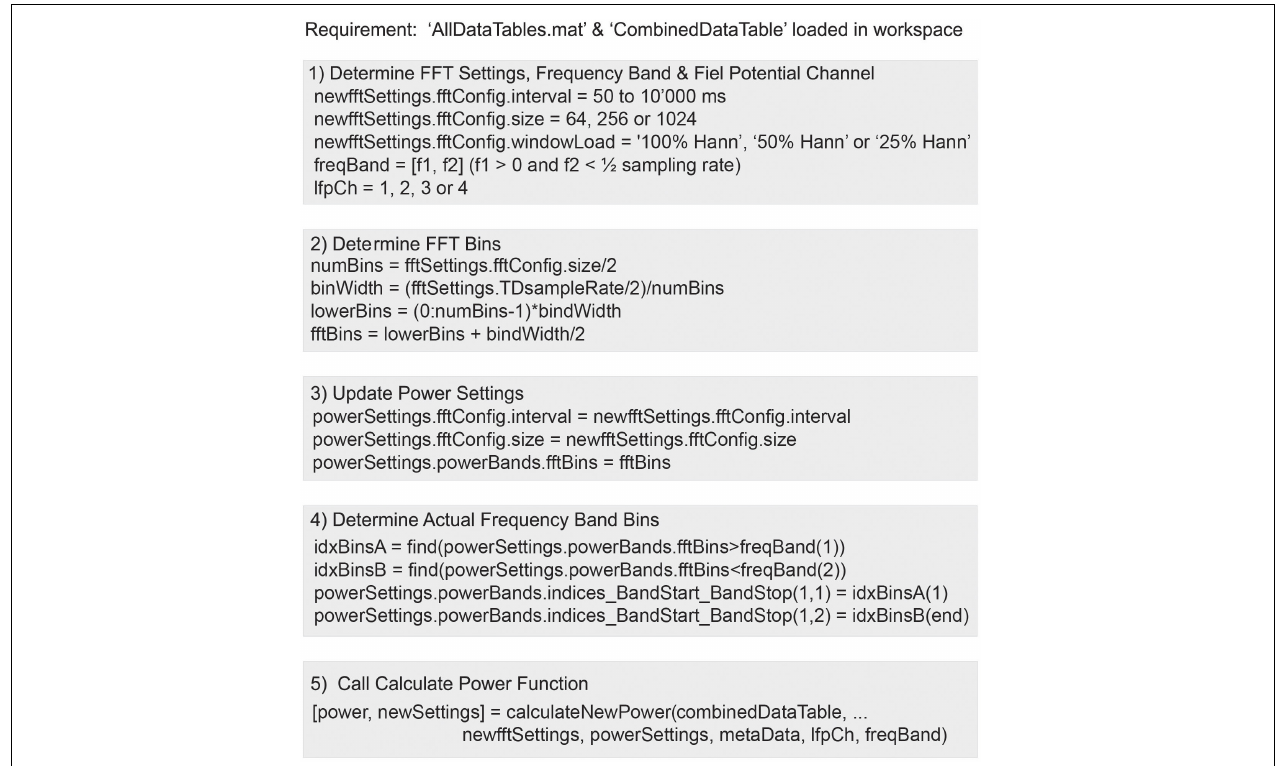
FIGURE 7 | Use of the function calculateNewPower.m to calculate a new power domain time series based on user-defined FFT settings, frequency band, and time domain channel. The steps required before invoking the function include: (1) Define FFT settings, frequency band, and time domain channel. (2) Calculate FFT bins. (3) Define Power Settings using the FFT settings and derived FFT bins. (4) Determine FFT bins within frequency band. (5) Run function calculateNewPower.m passing all required parameters.